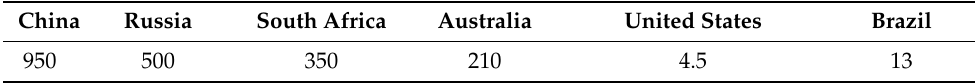
Table 2. Global vanadium ore reserve calculated by metallic vanadium in 2018 (10 kt) [30].